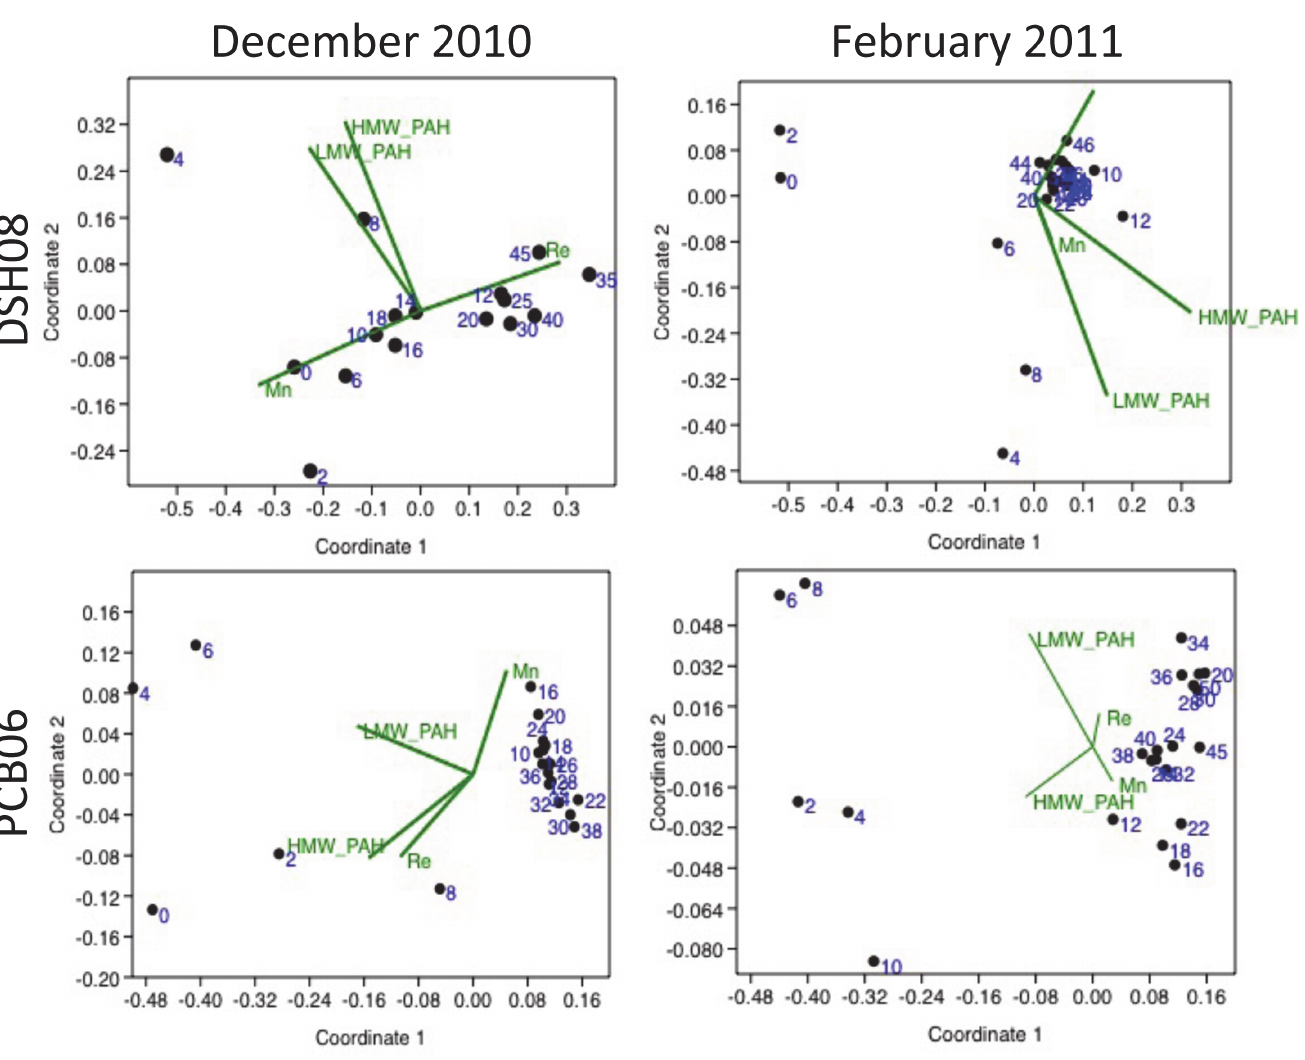
Fig 4. Non-metric multidimensional scaling plots for each core, where black dots represent the foraminiferal density at each sample interval (depths labeled in blue) and green vectors represent each environmental variable (HMW PAH, LMW PAH, Re, Mn)[28,29]. The Euclidian distance between each sample depth represents the Bray Curtis similarity and the orientation and length of the green vectors represent the correspondence and intensity of each environmental parameter to the variability between foraminiferal